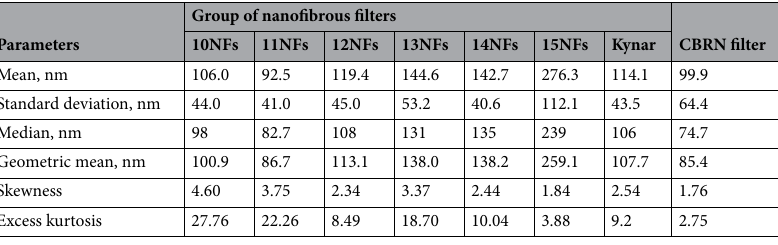
Table 2. Descriptive statistics of the nanofiber diameter